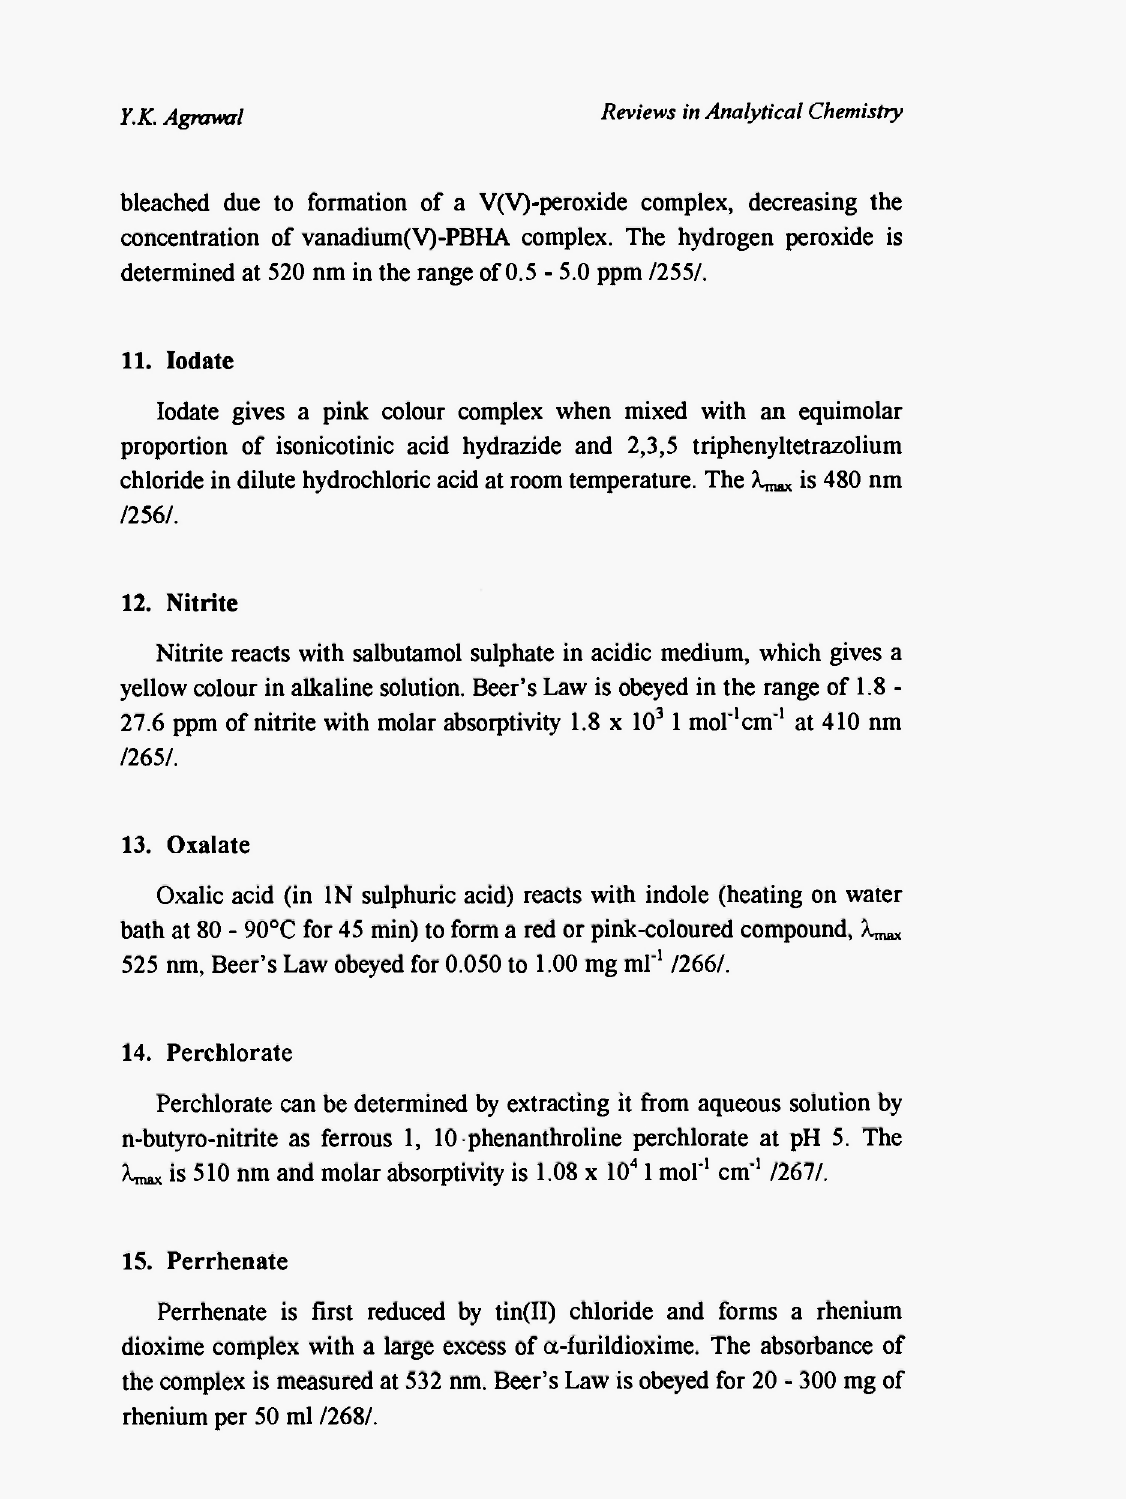
15. Perrhenate Perrhenate is first reduced by tin(II) chloride and forms a rhenium dioxime complex with a large excess of α-iurildioxime. The absorbance of the complex is measured at 532 nm. Beer's Law is obeyed for 20 - 300 mg of rhenium per 50 ml